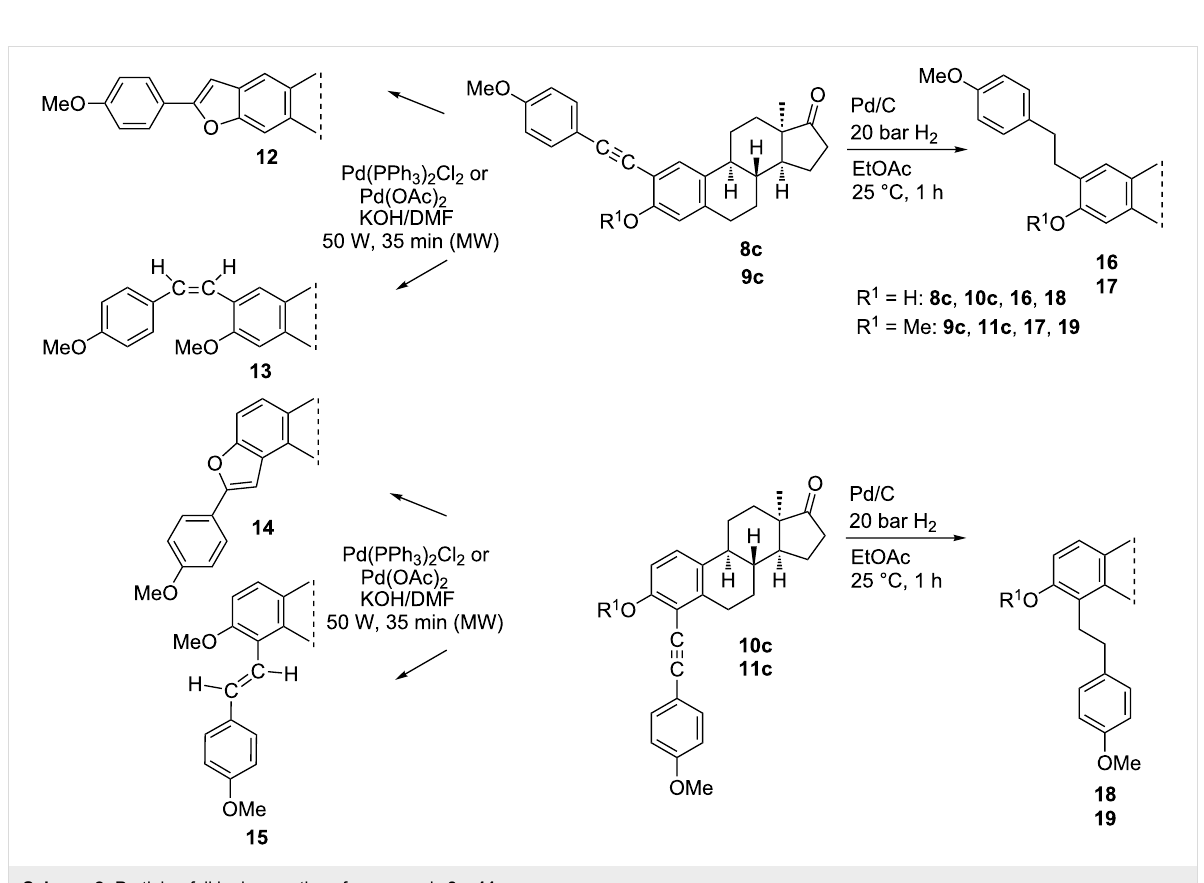
Scheme 1: Syntheses of 2- or 4-phenethynyl-13 α -estrones ( 8 – 11 ) by Sonogashira coupling.